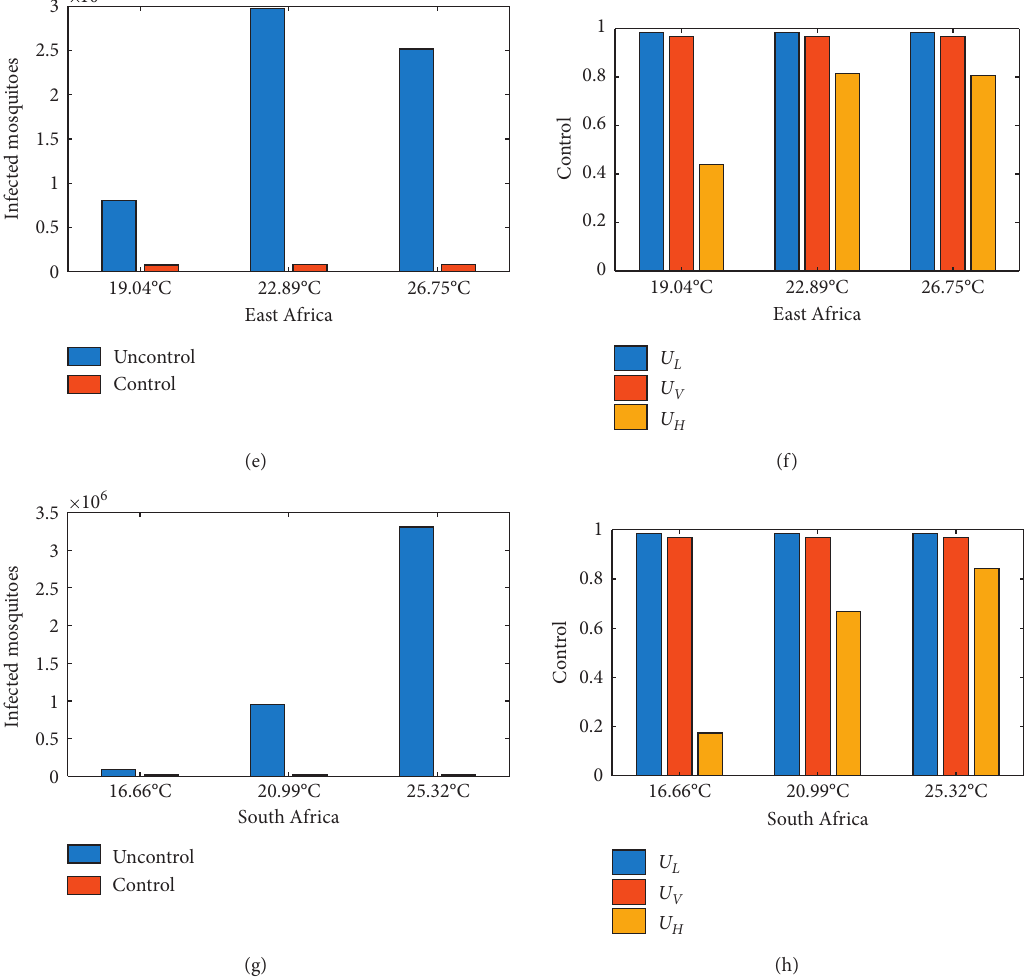
Figure 15: Simulations of the malaria-resistant model (21) as a function of time in the suitable temperature ranges. (a, c, e) The monthly total number of infected mosquitoes with control and (b, d, f) optimal controls u H ( t ) ,u L ( t ) , and u V ( t ) , in West, Central, East, Central, and South